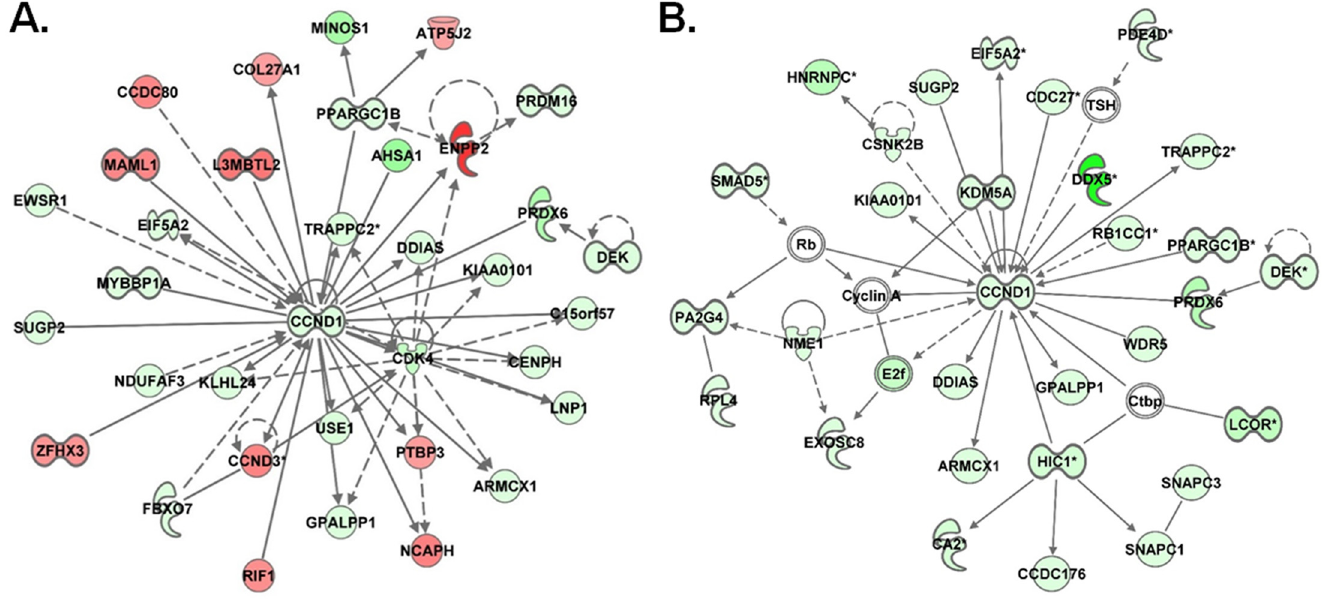
Fig 3. Highest scoring gene molecular networks of mRNAs and miRNA-mRNA target pairs in MWCNT high exposure group. Gene signaling network analysis by IPA of differentially expressed (A) mRNAs and (B) miRNA-mRNA target pairs in high MWCNT exposure group. The datasets either containing all differentially expressed genes or genes having consistent expression direction based on differentially expressed miRNAs were uploaded into IPA then analyzed with the cutoff criteria of (cid:5) 1.5 fold change and a p-value < 0.05. Only the network is presented for each group. Intensity of the red (upregulated) or green (down regulated) color of the nodes in the graph indicates level of gene